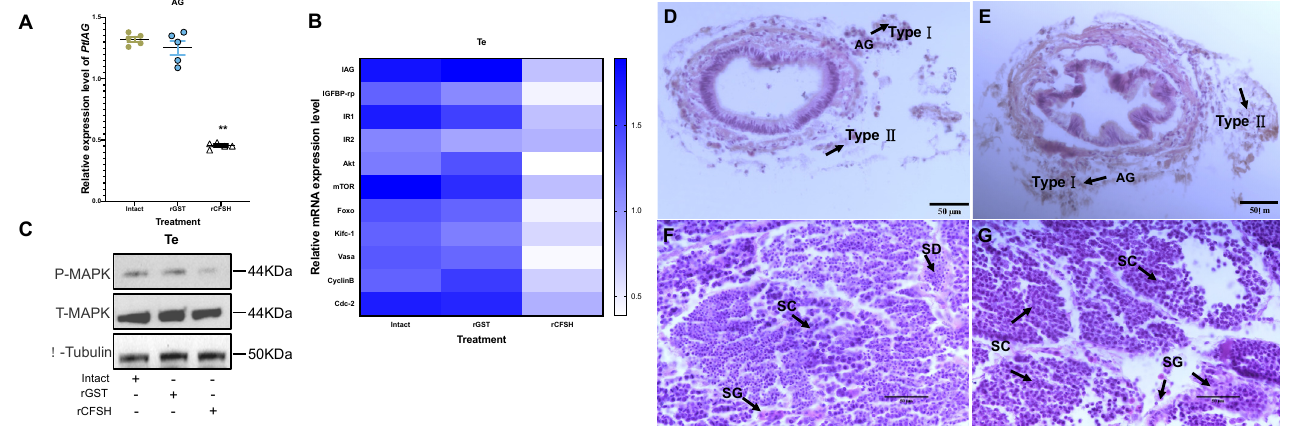
Figure 4. Effects of long-term rPtCFSH injection on gene and protein expression of P. trituberculatus . ( A ) Effect of rPtCFSH on PtIAG in AG tissue. The expression levels of PtIAG were examined in the intact group and after the in vivo injection of rGST and rPtCFSH. ** indicates acceptance p < 0.01 . ( B ) Effect of rPtCFSH on a series of genes in the testis. The heatmap levels of PtIAG , PtIGFBP-rp , PtIR1 , PtIR2 , PtAkt , PtmTOR , PtFoxo , PtKifc -1, PtVasa , PtCyclinB , PtCdc -2 were examined in the intact group and after the in vivo injection of rGST and rPtCFSH. Different colors of the same tested gene between the experimental and control groups indicated significant differences. The darker the color in the heat map, the higher the relative expression of the tested genes and vice versa. ( C ) Effect of rPtCFSH on phosphorylated-MAPK in testis. Phosphorylated MAPK, total MAPK and β -tubulin were detected in the intact group, rGST and rCFSH injection groups, with T-MAPK and tubulin serving as internal references. ( D ) Histological sectioning and H&E staining of AG after rGST injection. The arrows indicate type I and II AG cells, and the scale bar is marked in the lower right corner. ( E ) Histological sectioning and H&E staining of AG after rPtCFSH injection. The arrows indicate type I and II AG cells, and the scale bar is marked in the lower right corner. ( F ) Histological sectioning and H&E staining of the testis after rGST injection. The arrows point to the spermatogonia (SG), spermatocytes (SC) and spermatid (SD), respectively. The scale bar is shown in the lower right corner. ( G ) Histological sectioning and H&E staining of testis after rPtCFSH injection. The arrows point to the spermatogonia (SG), spermatocytes (SC) and spermatid (SD), respectively. The scale bar is shown in the lower right corner. Vertical bars represent means ± SEM (n = 5). Significant differences among stages are indicated by different letter labels (one-way ANOVA followed by post hoc Tukey’s multiple group comparison p < 0.05).